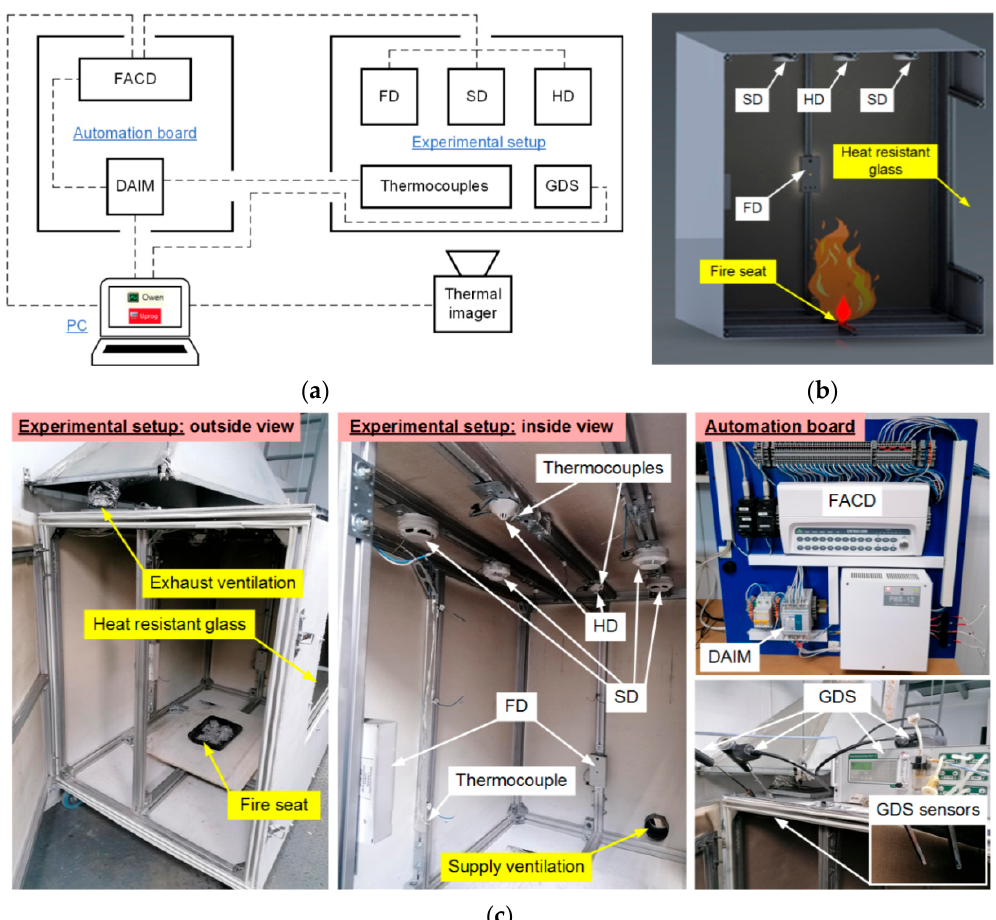
Figure 1. Architecture of experimental complex ( a ), setup layout ( b ), appearance of the main elements ( c ): FACD—Fire alarm control device, DAIM—Digital and analog input module, FD—Flame detector, SD—Smoke detector, HD—Heat detector, GDS—Gas detection system.